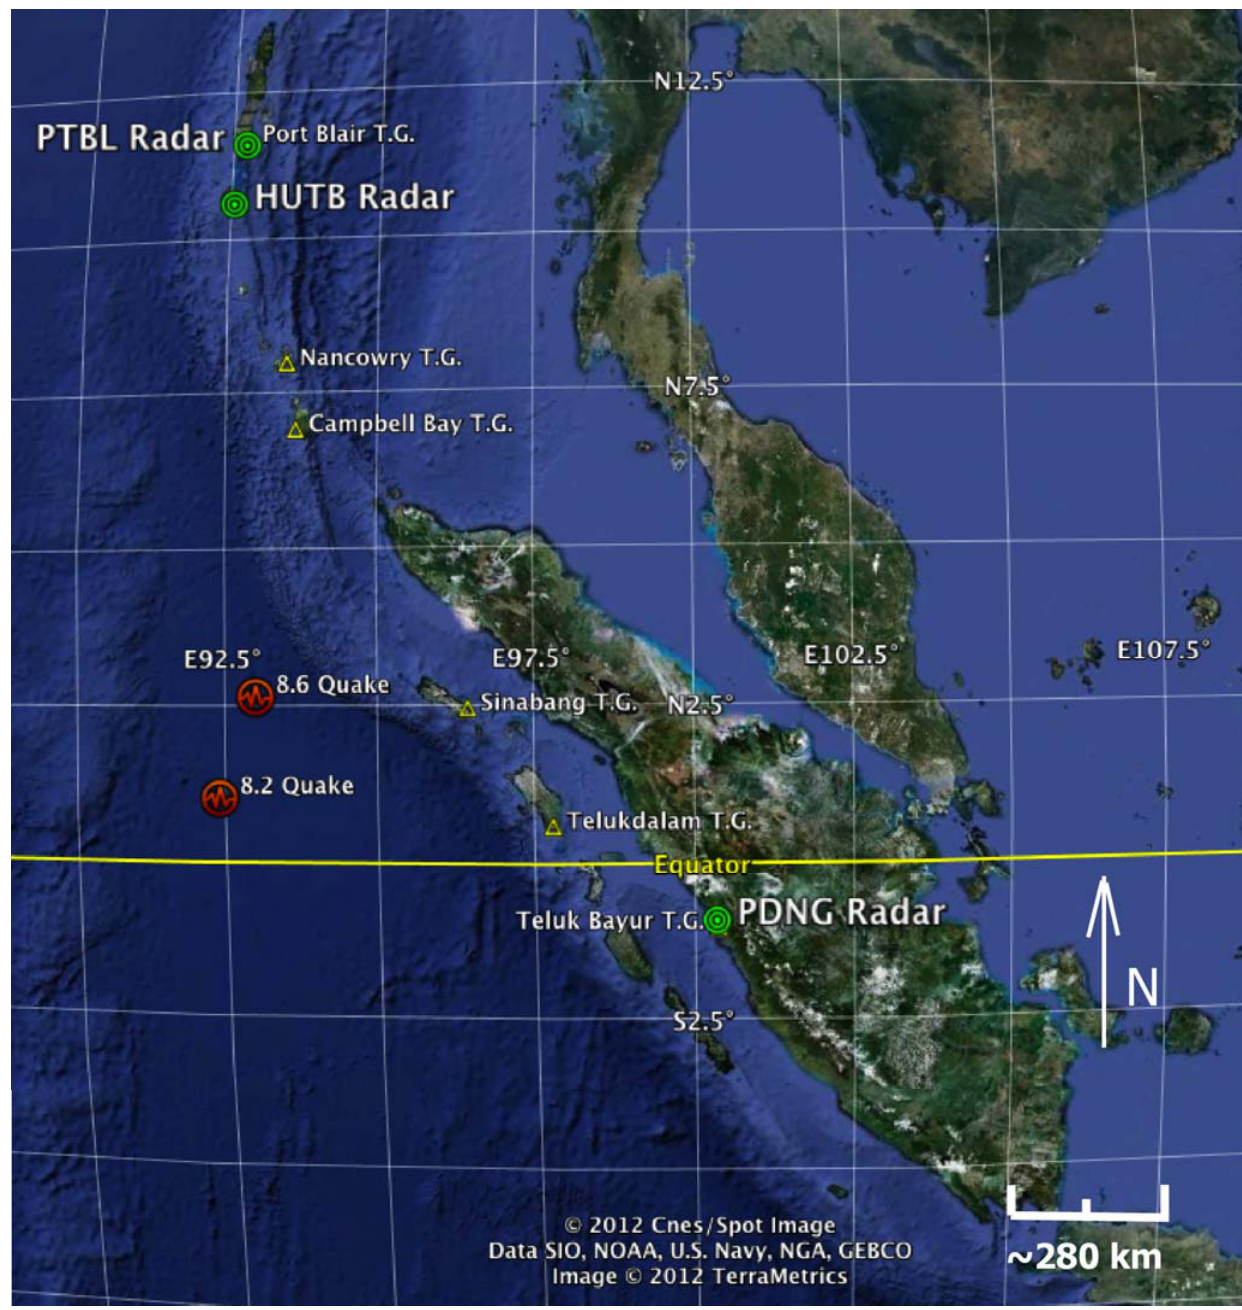
Figure 1. Locations of the 8.6 and 8.2 magnitude earthquakes, occurring April 11 at 8:38 and 10:43 UTC, radars at Padang (PDNG), Hut Bay (HUTB), Port Blair (PTBL) and neighboring tide gauges